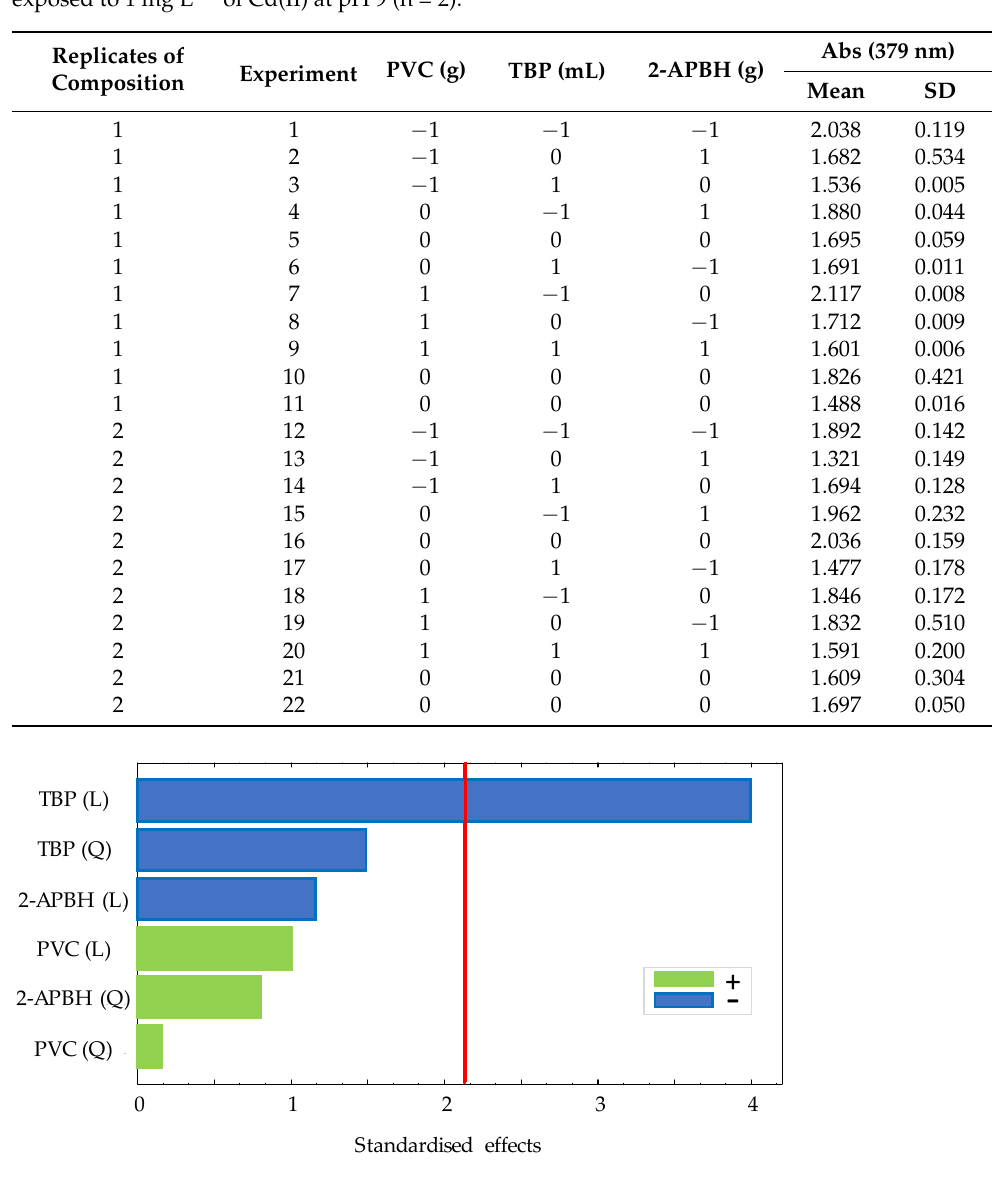
Figure 2. Pareto chart for 3 (3 − 1) experimental design for optical sensor response (red line: significance level of 5%).